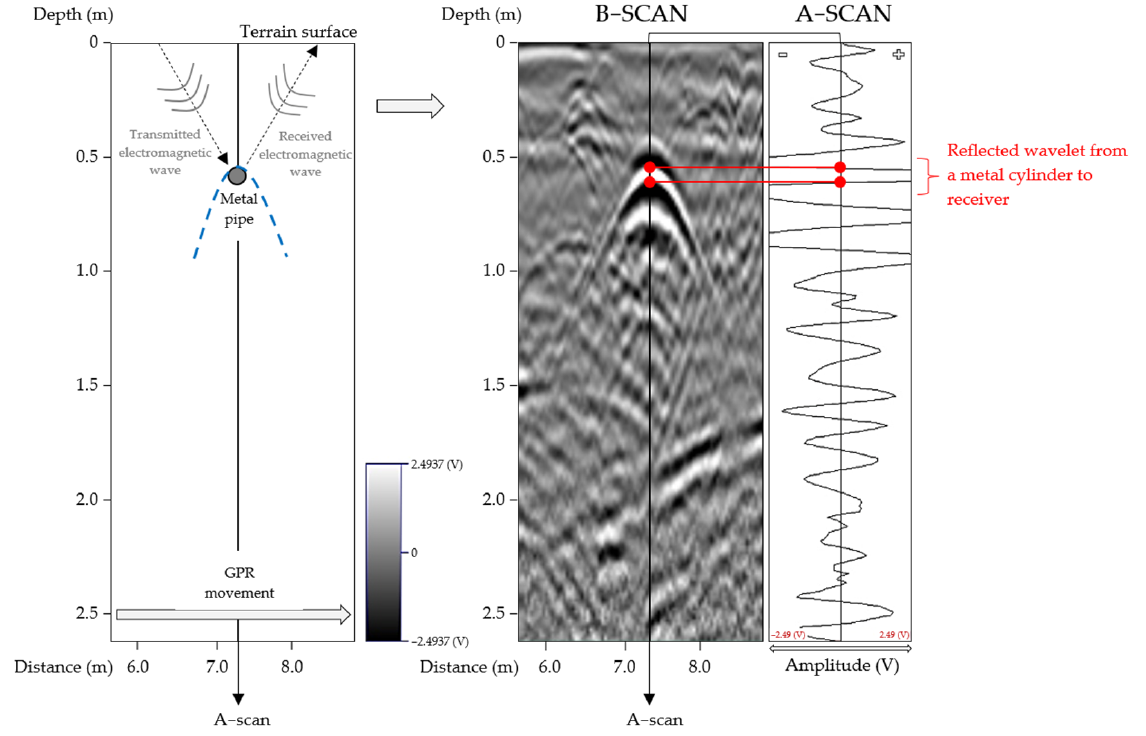
Figure 1. Presentation of the location of the underground facility on the A − scan and B − scan.